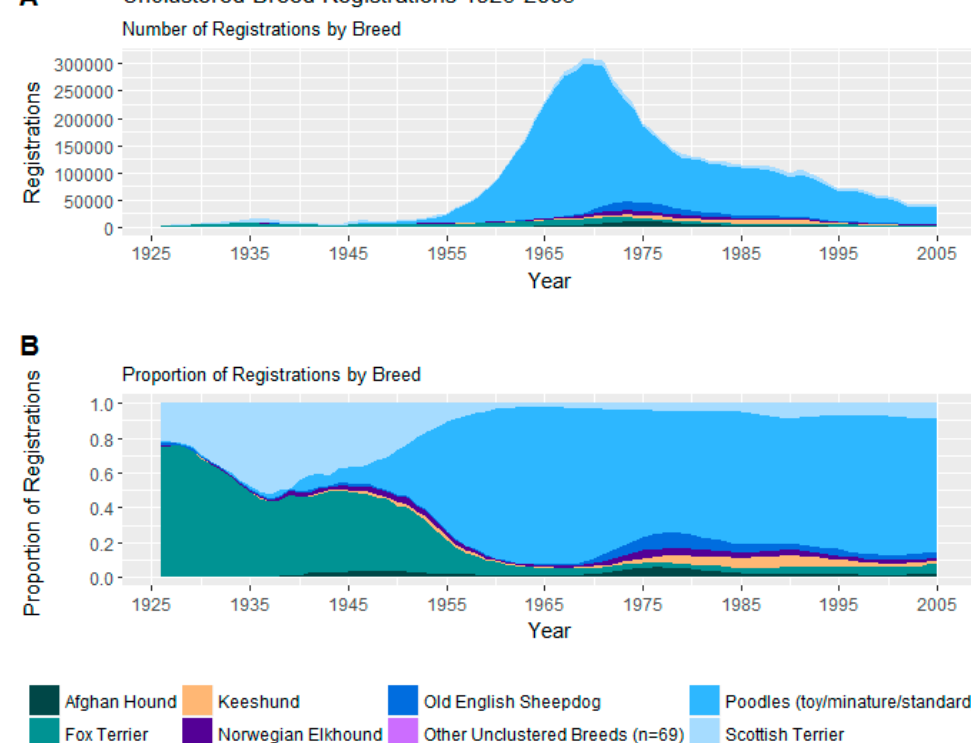
Figure 9. ( A ) Number of registrations; ( B ) and proportion of registrations within the unclustered breeds.